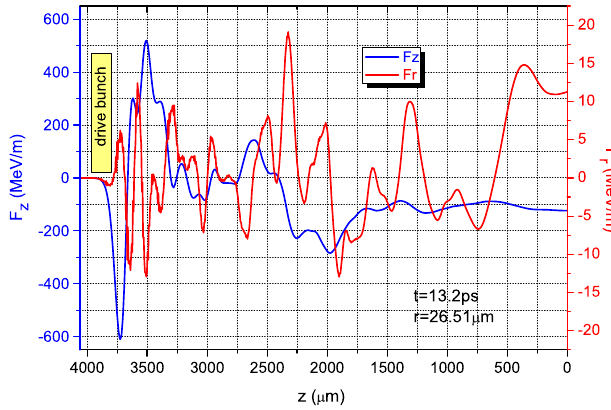
FIG. 16. (Color) Axial wakefields at the centers of drive (red line) and accelerating channels (blue line) of the coaxial DWFA for time t ¼ 13 : 2 psec when the drive bunch center is located at z ¼ 3880 (cid:1) m from the entrance from the structure ( z ¼ 0 ).